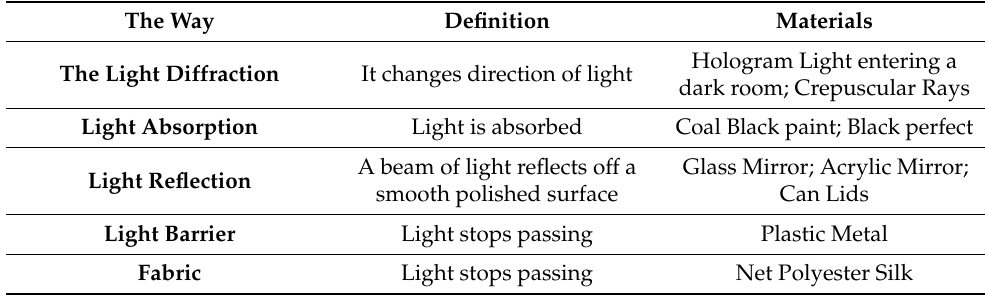
Table 7. Protection way against laser